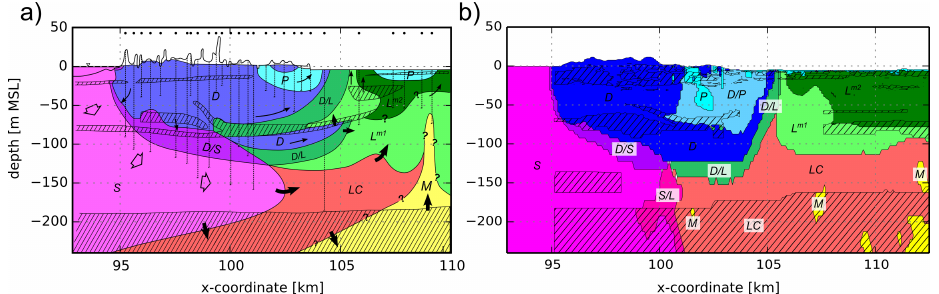
Figure 6. Position of hydrosomes, inferred from hydrochemical facies analysis (adapted from Fig. 4.6 in Stuyfzand, 1993) (a) and from modeled origin tracers (b) . Capitals denote discerned hydrosomes: D = dune (also containing nested artificial recharge hydrosome; not shown), LC = Holocene transgression (L) – coastal type, L m1 = L – ancient marsh type, L m2 = L – young marsh type, M = Maassluis, P = polder, S = (actual) North Sea. See Sect. 2.3 for a description of discerned hydrosomes, and Table 1 for the mapping of origin tracers to hydrosomes, dots and dashed lines in (a) denote locations of piezometers used in HYFA.